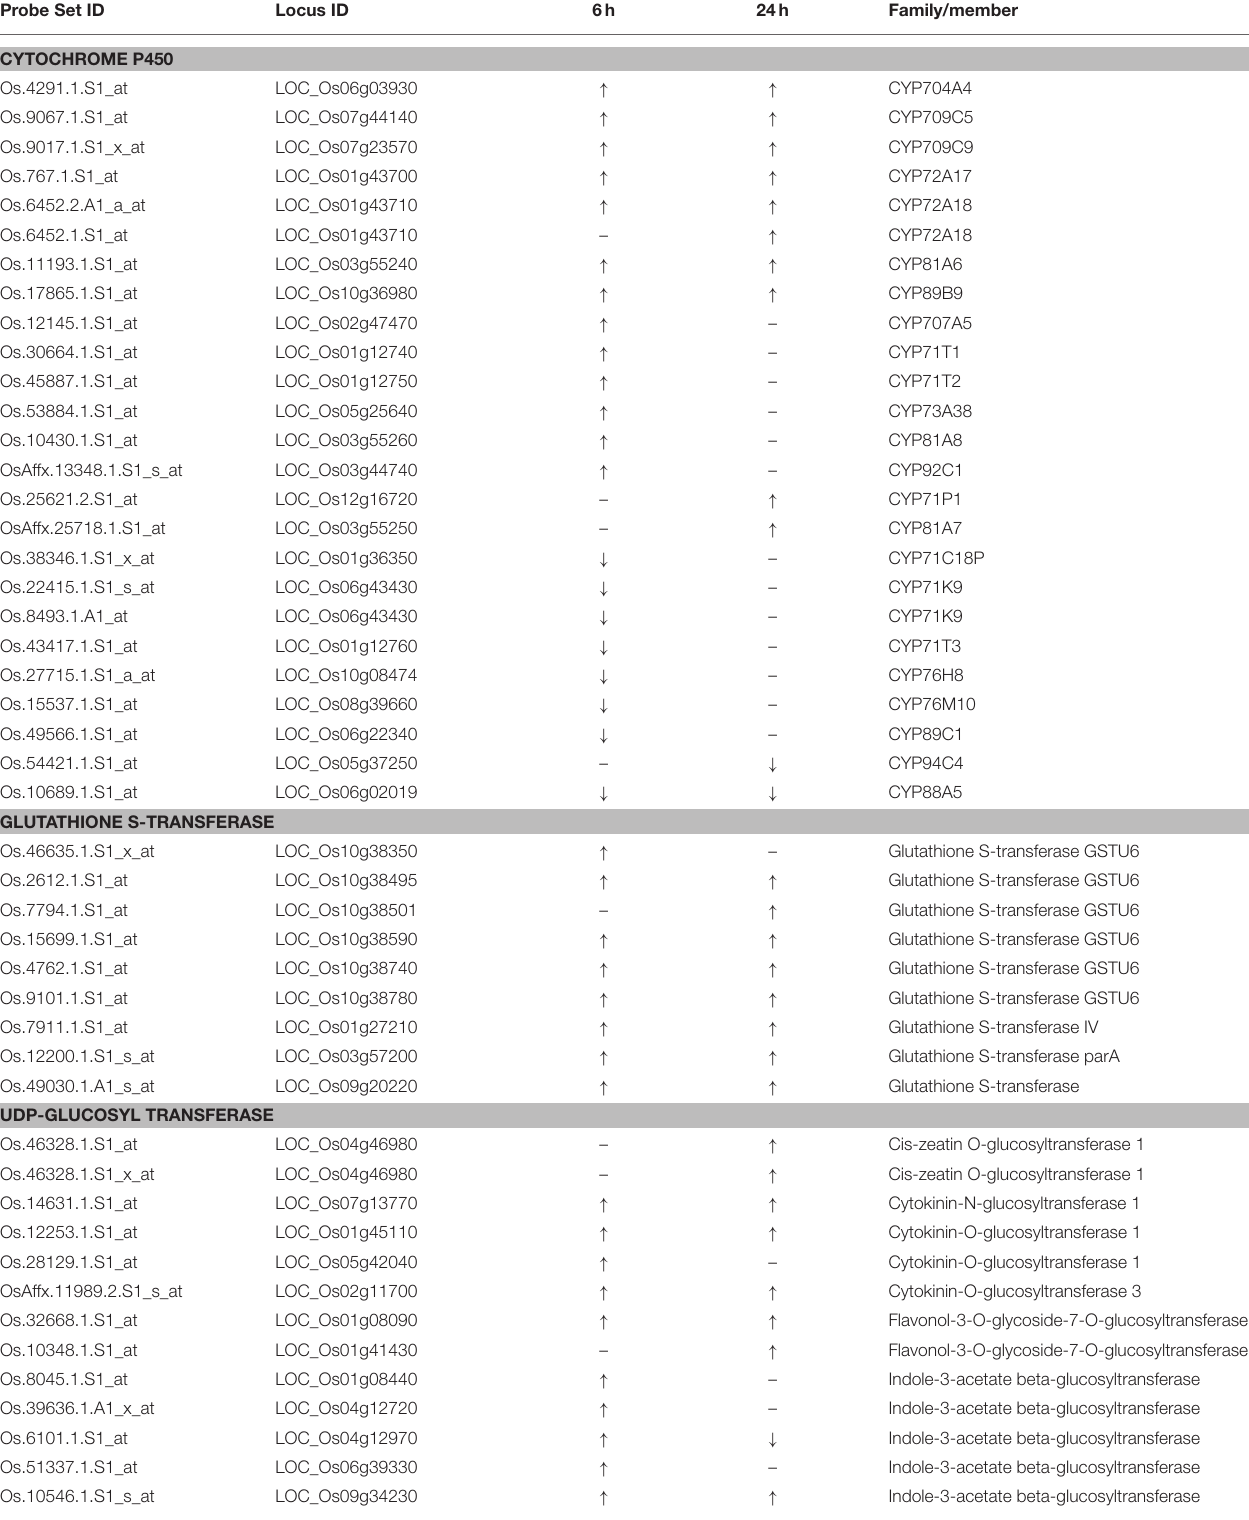
TABLE 1 | The quinclorac-responsive genes related to significant GO